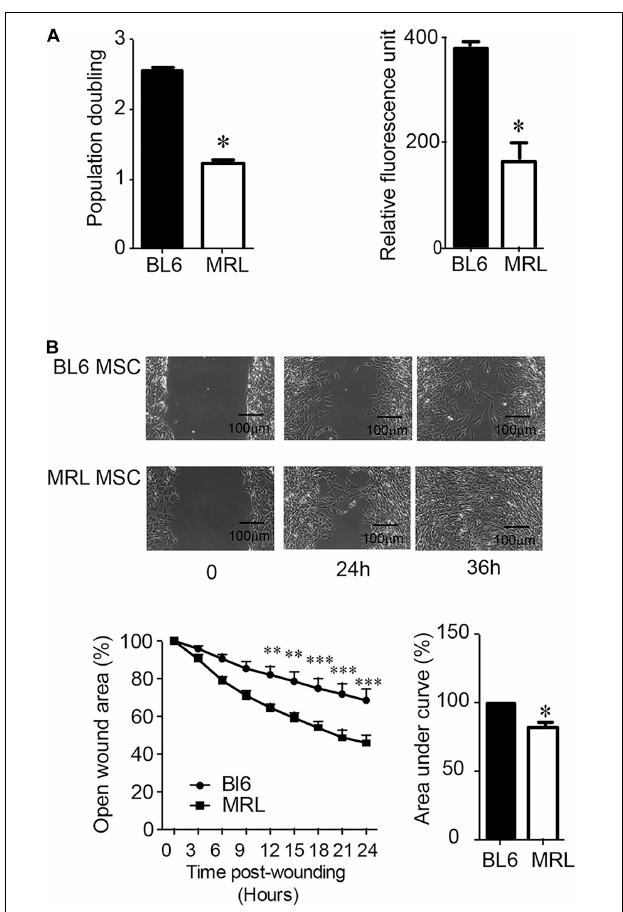
FIGURE 2 | MRL MSC exhibit a lower proliferation rate and a higher migration potential than BL6 MSC. (A) The proliferation potential of BL6 and MRL MSC was evaluated after an overnight synchronization in absence of serum and a 7 days culture period in complete medium by either calculating the number of population doublings, i.e., the total number of times MSC has doubled from the moment we seeded (D0) them until D7 using the formula Population Doubling = 3.33 log 10 (number of MSC at D7/number of MSC plated at D0). We also used the PrestoBlue assay (Relative fluorescence unit) to evaluate the proliferation potential of the SMC. Results represented as mean ± SEM ( n = 3 replicates). (B) Migration of MRL and BL6 MSC were analyzed in a scratch wound assay by evaluating the area of the wound at 0, 3, 6, 9, 12, 15, 18, 21, 24, and 36 h after wounding. Representative images from scratch wound healing assay (on the top). Measure of the open wound area (bottom). 100% correspond to the highest wound area measured at 0 h using Image J software. The area under curve (AUC) was calculated from the curve of open wound area percentage over the healing period (0–24 h). Results represented as mean ± SEM ( n = 5 replicates). *p ≤ 0.05, ** p < 0.01, *** p < 0.001.